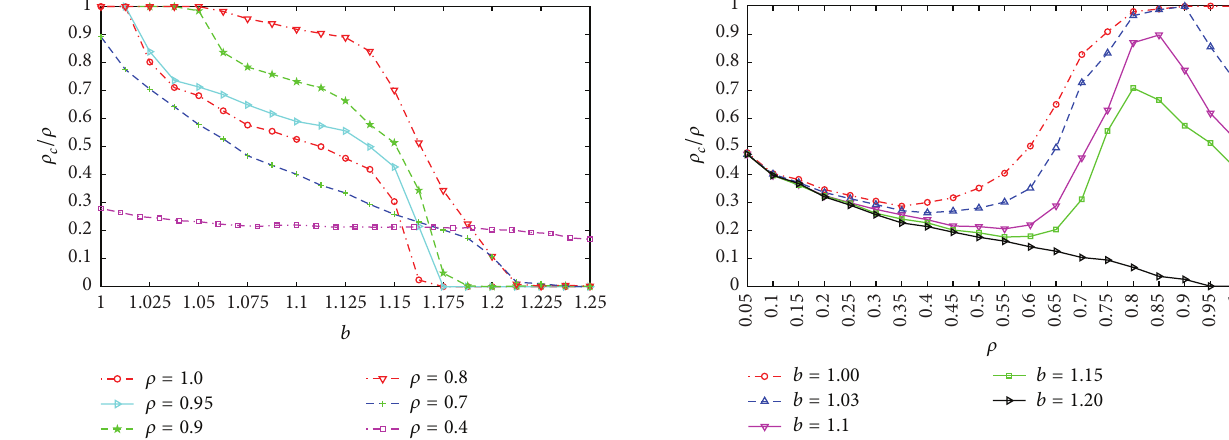
Figure 2: Relative density of cooperators 𝜌 𝑐 /𝜌 in dependence on the Figure 1: Relative density of cooperators 𝜌 𝑐 /𝜌 as a function of occupation fraction 𝜌 for different values of 𝑏 when 𝜇 = 0.5 and temptation to defection 𝑏 for different values of 𝜌 when 𝜇 = 0.5 𝛼 = 3 (see legend). Irrespective of the value of 𝑏 , the relative density and 𝛼 = 3 (see legend). For 𝜌 = 0.9 or 0.8, the cooperation level is ofcooperators 𝜌 𝑐 /𝜌 decreasesfromaround0.485withtheincreaseof profoundly enhanced for a wide range of values of 𝑏 . However, the 𝜌 ,andthenthecurvesfordifferentvaluesof 𝑏 departaround 𝜌 = 0.1 . cooperation level is deteriorated for smaller values of 𝜌 , for example, /𝜌 decreases 𝜌 = 0.7 .When 𝜌 = 0.4 ,relativedensityofcooperators 𝜌 Still further, there are three interesting cases: the first interesting 𝑐 case occurs if 𝑏 = 1.0, where the relative density of cooperators 𝜌 𝑐 /𝜌 monotonically and slightly with the increase of 𝑏 . increases monotonically with the increase of 𝜌 until approaching a unity; the second interesting case occurs if 𝑏 is in the region, 1.05 < 𝑏 ≤ 1.175 , where the relative density of cooperators increases monotonically with the increase of 𝜌 until reaching its maximum value and then sharp decreases; the third interesting case appears if 𝑏 is in the region 𝑏 > 1.175 , for example, 𝑏 = 1.2 , where the relative density of cooperators decreases monotonically with the increase of 𝜌 until approaching